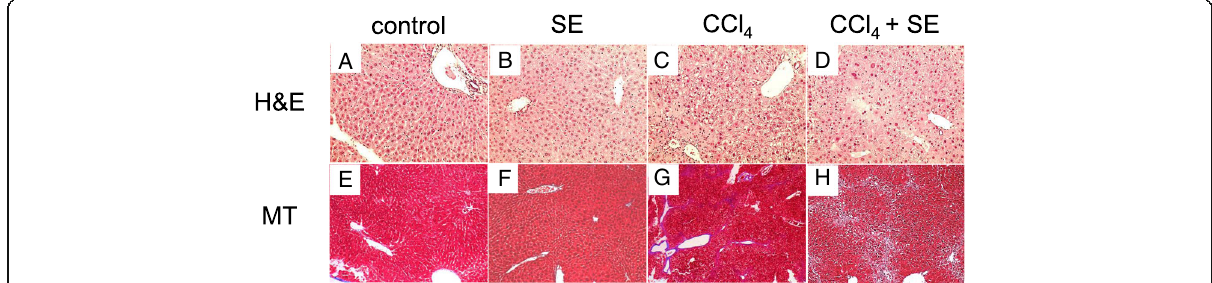
Fig. 5 SE treatment protects animals from repeated CCl 4 -induced hepatotoxicity, as assessed by H&E staining and MT staining. Animals treated as described in Fig. 2 were euthanized at 72 h post intraperitoneal injection, and the livers were harvested at necropsy. Liver specimens were fixed and processed by standard methods, and sections were stained with H&E and MT. Data in a – d indicate H&E stain and e – h indicate MT stain, respectively. Necrotic area and aniline blue-positive area were calculated using ImageJ software.